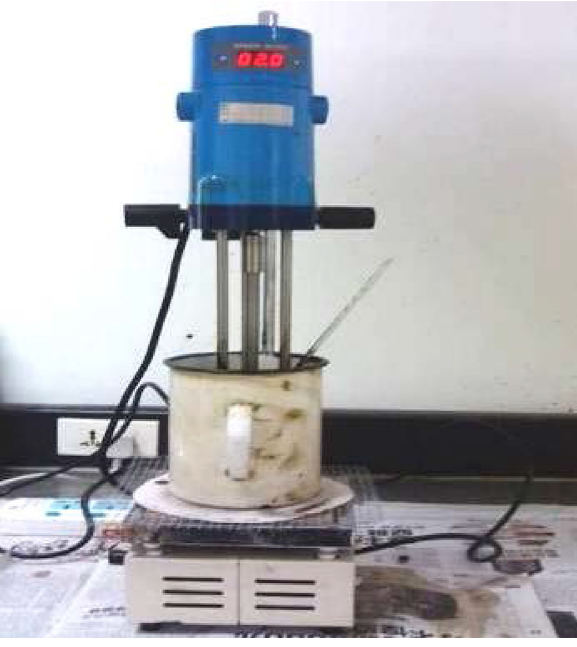
Fig. 1 Preparation of high-viscosity modified asphalt